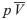
Varying oncogene expression rates.(a) Bifurcation diagram showing cleared W (area below the curve) versus chronic W (area above the curve) as the tat effect pV¯ and CTL carrying capacity K(T¯) vary. Here, the criterion for HPV clearance is given by Eq (7); (b) HPV W; and (c) CTL E as given by model (6) for parameters listed in Table 1 and ε = 0.1 (blue solid lines), ε = 0.5 (red dashed lines), and ε = 0.9 (green dotted lines).